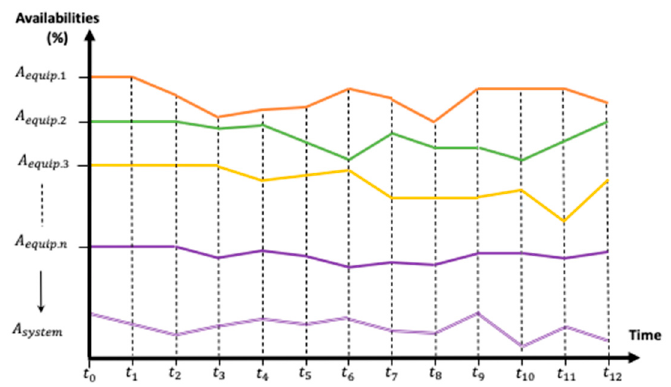
Figure 6. System availability as a result of individual availabilities and topological aspects.